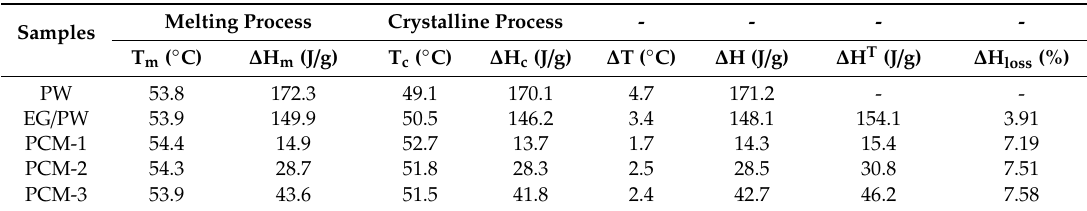
Table 1. Thermal characteristics of the PW, EG / PW and EG / PW / SR composite.